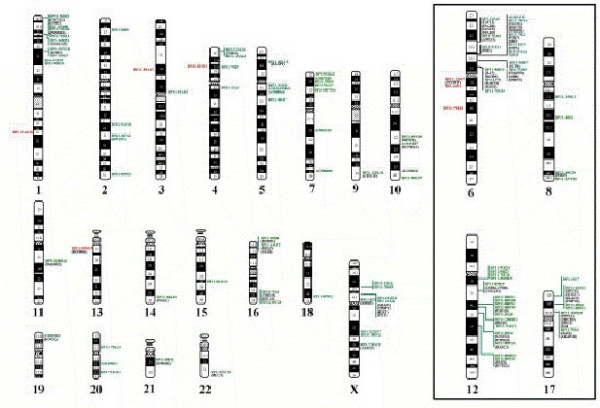
Ideogram showing recurrent homozygous deletions (left) and high-level amplifications (right) identified by array CGH in 48 cases. The gene(s) contained within the BAC clone are shown in parentheses of the respective clones. Gene(s) present in the BAC clones were identified using UCSC browser  by downloading gene table (refFlat) from human gene assembly, July 2003. The ideograms for chromosomes 6, 8, 12 and 17 are shown separately.